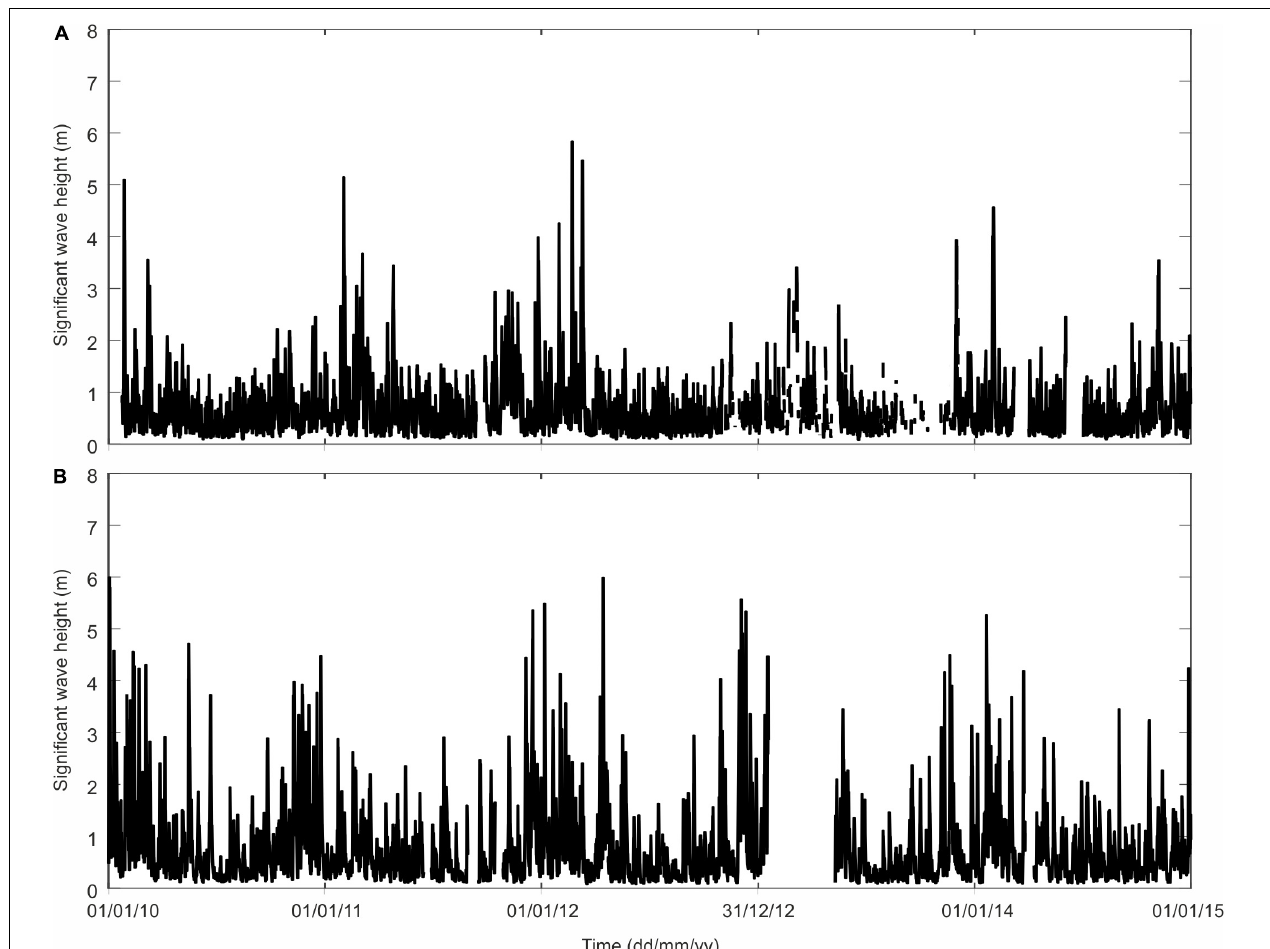
FIGURE 2 | Significant wave height time series recorded by the Catania (A) and Cetraro (B)